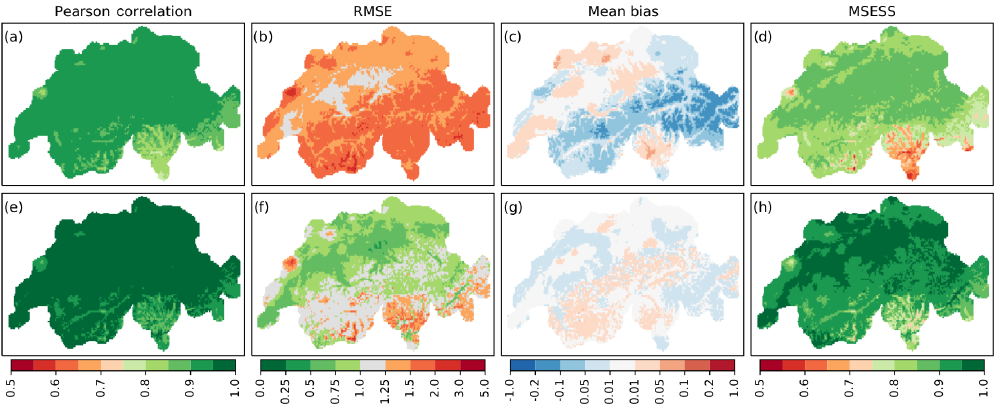
Figure 3. Validation of temperature over time during 1961–2017 for ARM (a–d) and EnKF (e–h) reconstructions. Shown are the Pearson correlation (a, e) , RMSE ( ◦ C) (b, f) , mean bias ( ◦ C) (c, g) , and MSESS (d, h)